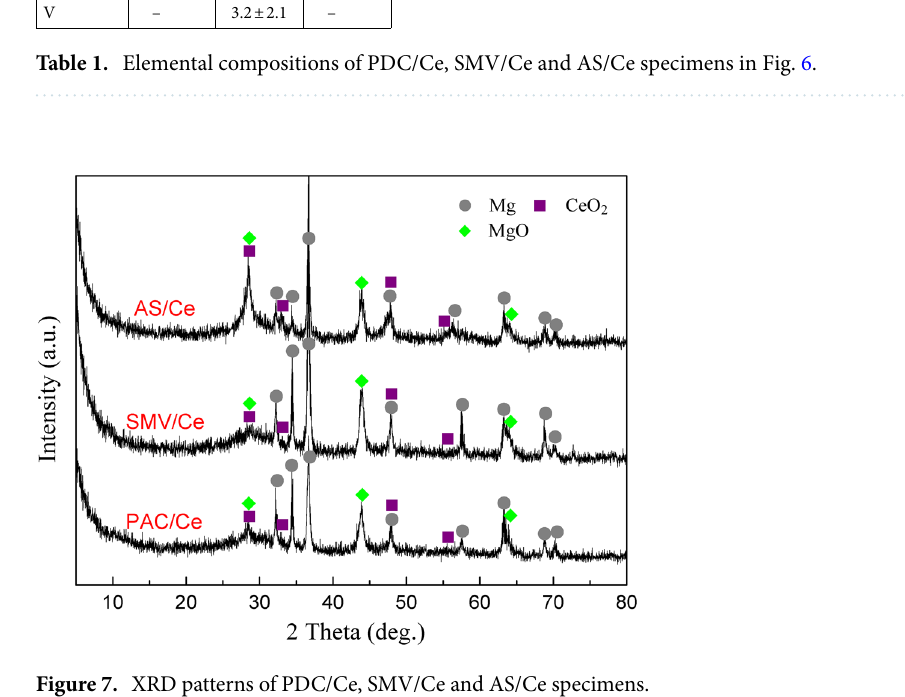
Figure 7. XRD patterns of PDC/Ce, SMV/Ce and AS/Ce